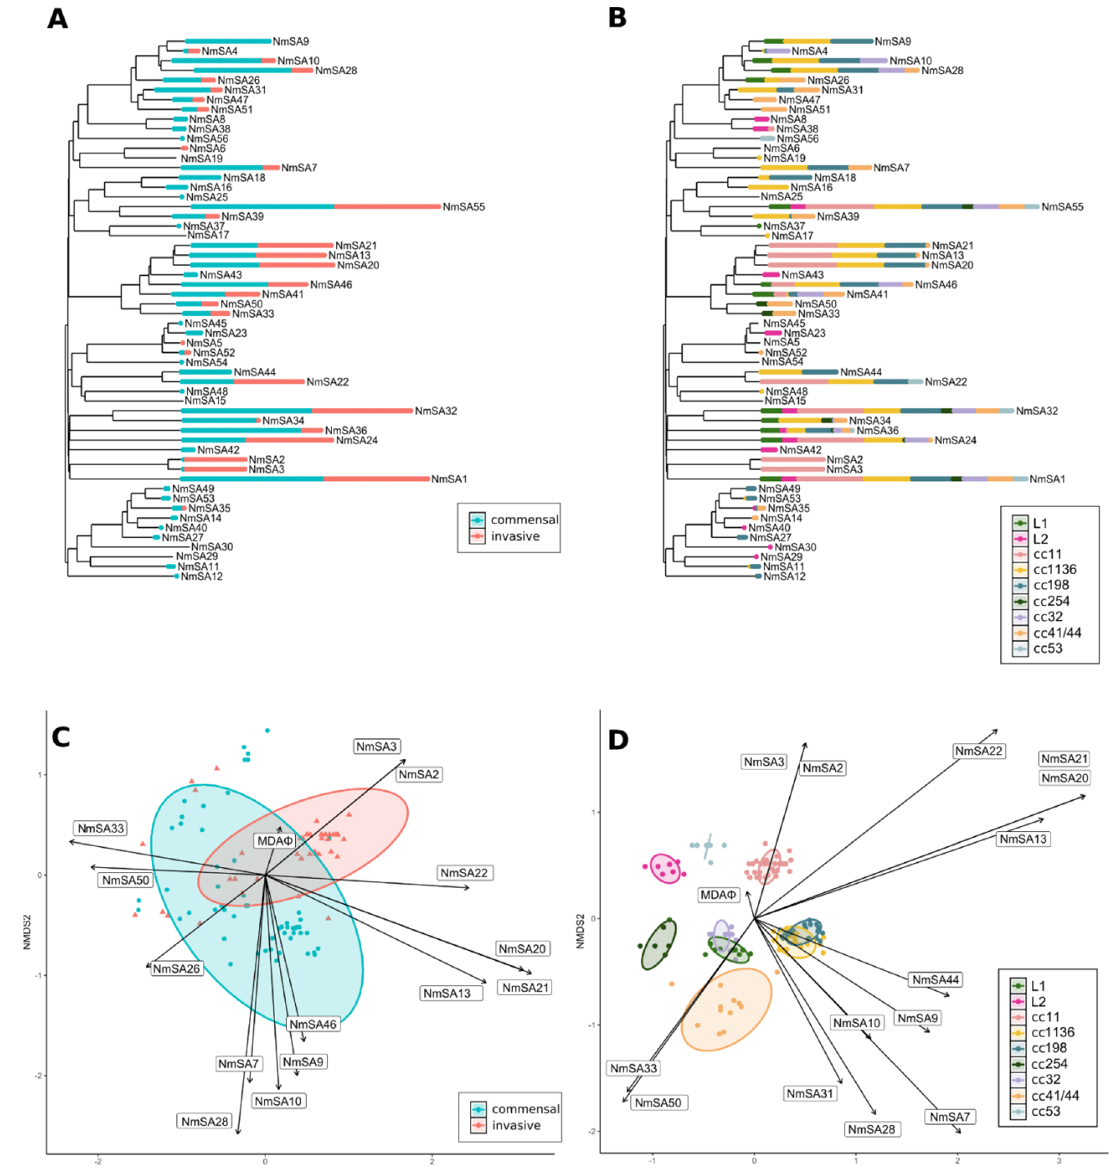
Figure 2. Prophage content related to epidemiological features in N. meningitidis from South America. The 56 species identified by the D6 VICTOR formula were used for this analysis [20]. The phyloge- netic tree was generated by D6-VICTOR and rooted at the midpoint. Prophage abundance in the genomes of N . meningitidis is represented according to pathogenicity ( A ) and clonal complexes ( B ). Non-parametric multidimensional scaling (NMDS) analyses, based on prophage content, show the relationship between prophage structure and pathogenicity ( C ) and clonal complexes ( D ). In the NMDS plots, only significant prophages (vectors) with an R 2 greater than 0.4 are represented, except for MDA, which was not significant and was only plotted as an initial reference point. Vectors are proportional to R 2